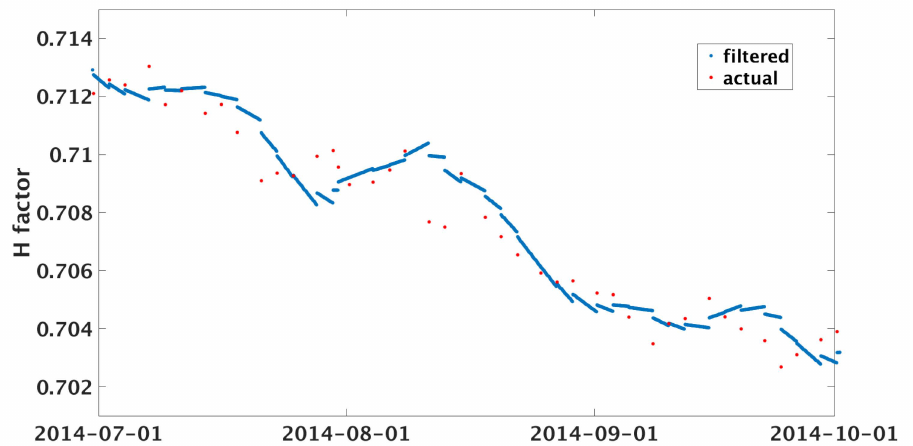
Figure 3. Comparison of the band M1 H factor values derived from the actual SDSM measurements without filtering and the values smoothed and interpolated with the RHW